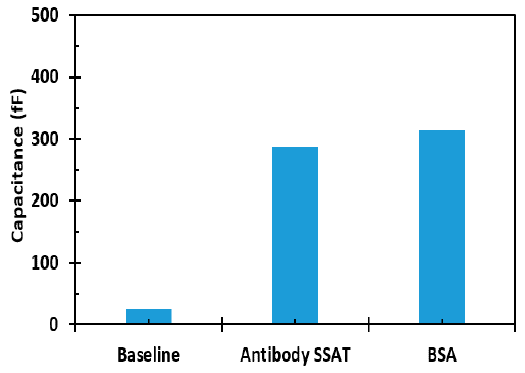
Figure 10. Measured baseline, antibody, and BSA capacitances of the sensor.